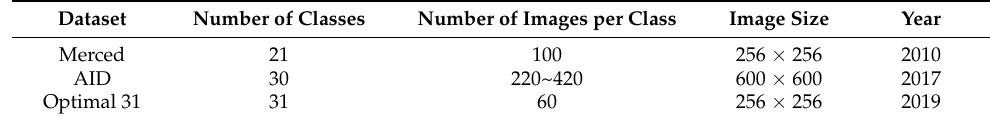
Table 2. Characteristic of the datasets.